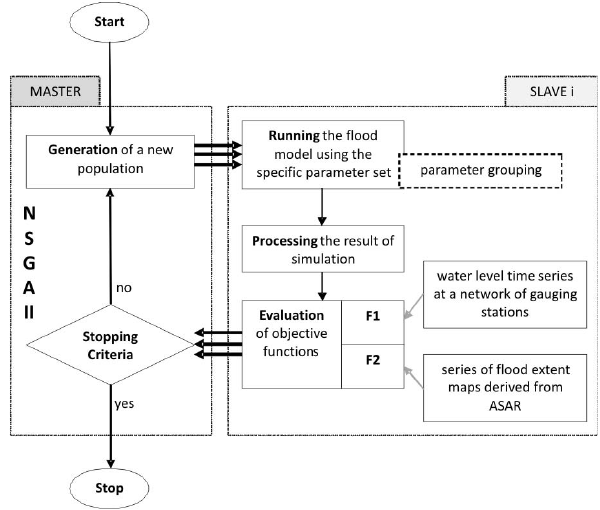
Fig. 5. The calibration framework for the hydrodynamic model. Table 2. Statistics of the hydrodynamic model of the Mekong